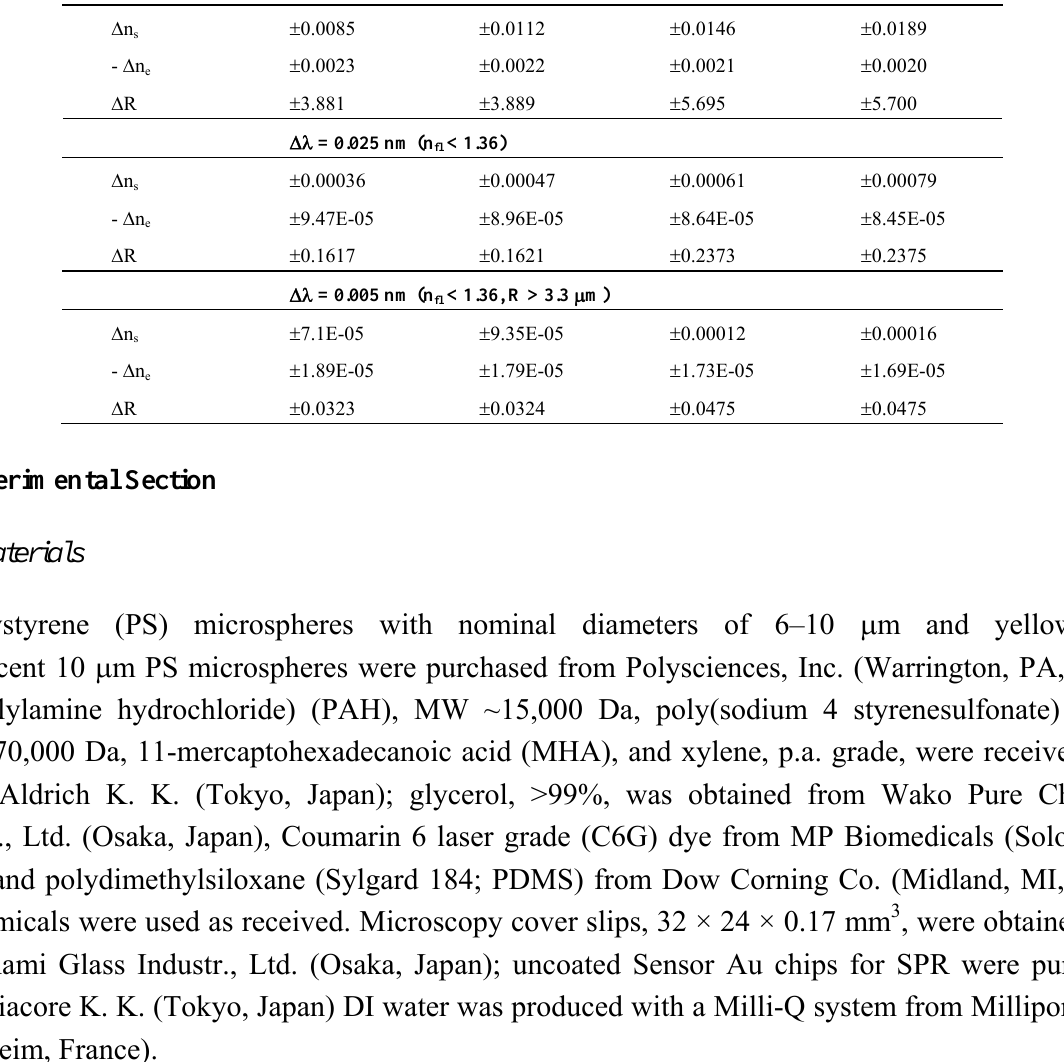
, environmental index, n , and bead radius, s e